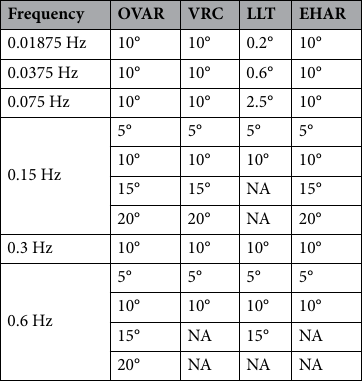
Table 1. Stimulus frequency and actual or simulated tilt angles used for each motion paradigm. OVAR off- vertical axis rotation (actual tilt), VRC variable radius centrifuge (simulated tilt), LLT linear-lateral translation (simulated tilt), EHAR Earth-horizontal axis rotation (actual tilt). NA indicates when motion was not possible due to device limitations.